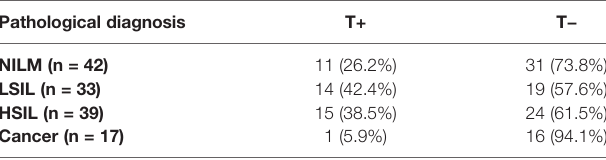
The progression from HPV infection to malignant tumor TABLE 2 | Results of HPV16 E7-speci fi c T lymphocyte response at study entry.